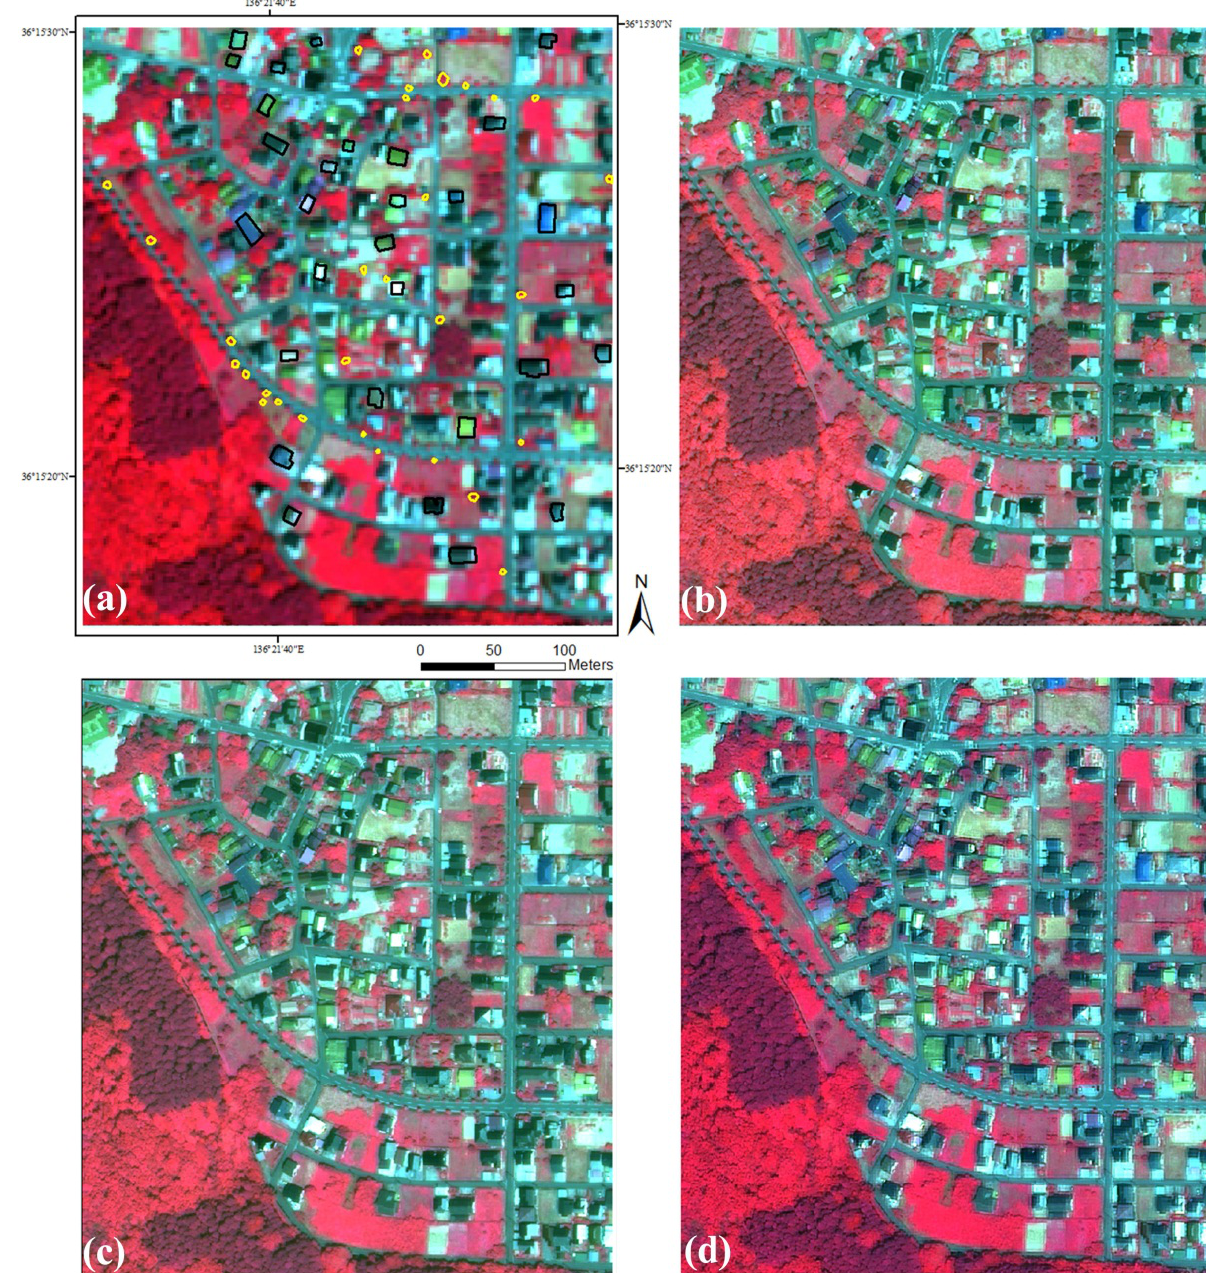
Figure 1. GeoEye-1 image (NIR, R, G bands) of ( a ) the residential study area. ( b ) Intensity-Hue-Saturation (IHS), ( c ) Brovey Transform (BT), and ( d ) Smoothing-Filter- Based-Intensity Modulation (SFIM) pansharpened images. Yellow polygons in (a) delineate reference tree polygons and black polygons delineate reference building polygons. A standard deviation contrast stretch of 2.0 was used for display